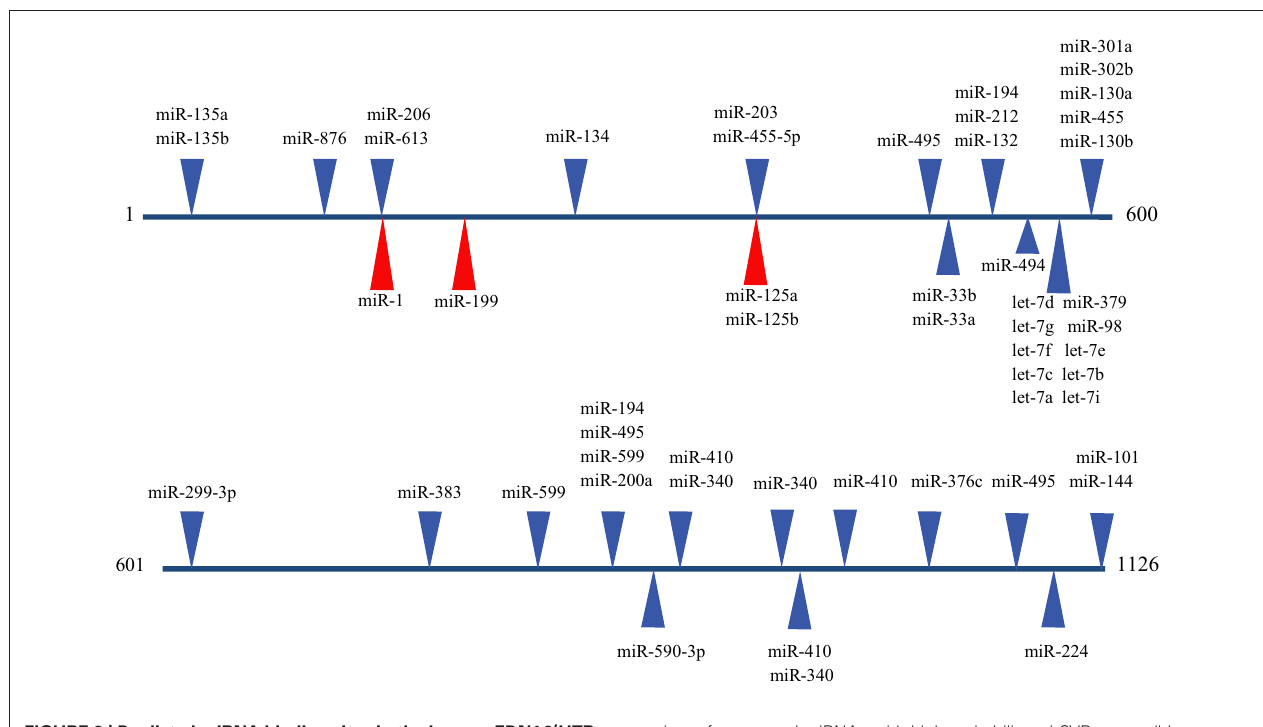
FIGURE 2 | Predicted miRNA binding sites in the human EDN1 3 (cid:2) UTR. Predicted miRNA target sites within the human EDN1 3 (cid:2) UTR (NM_001955) were determined using microRNA.org (Betel et al., 2008). Depicted are target